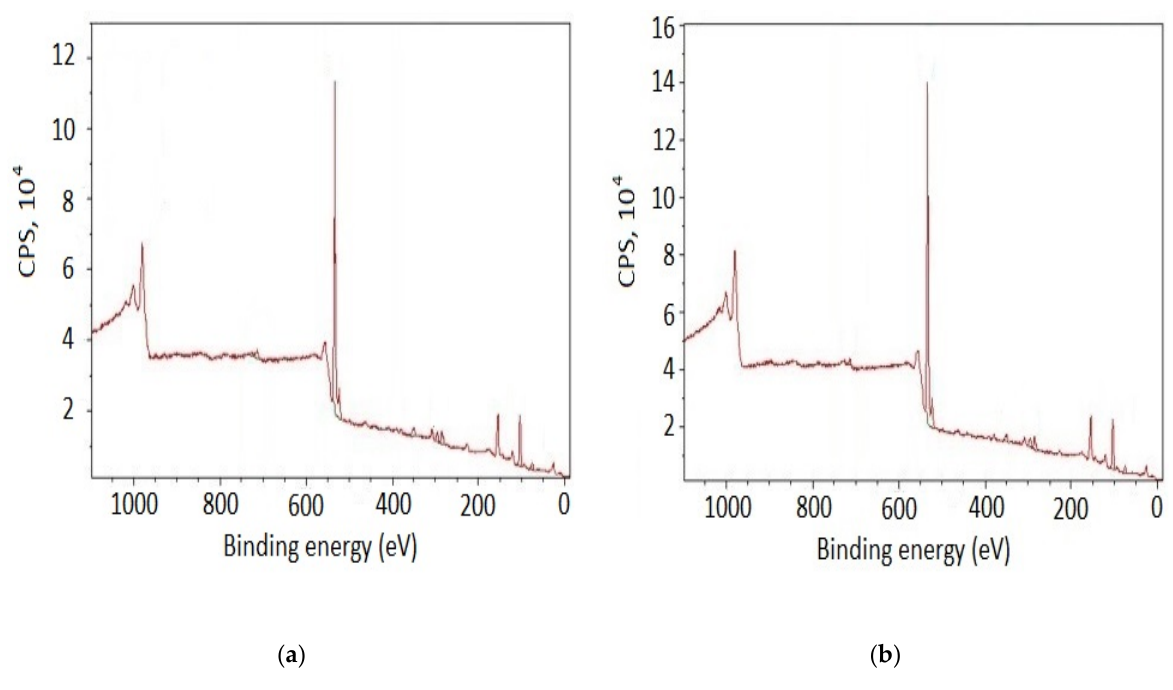
Figure 3. XPS analyses of ( a ) Z-M20, and ( b ) Z-M50.